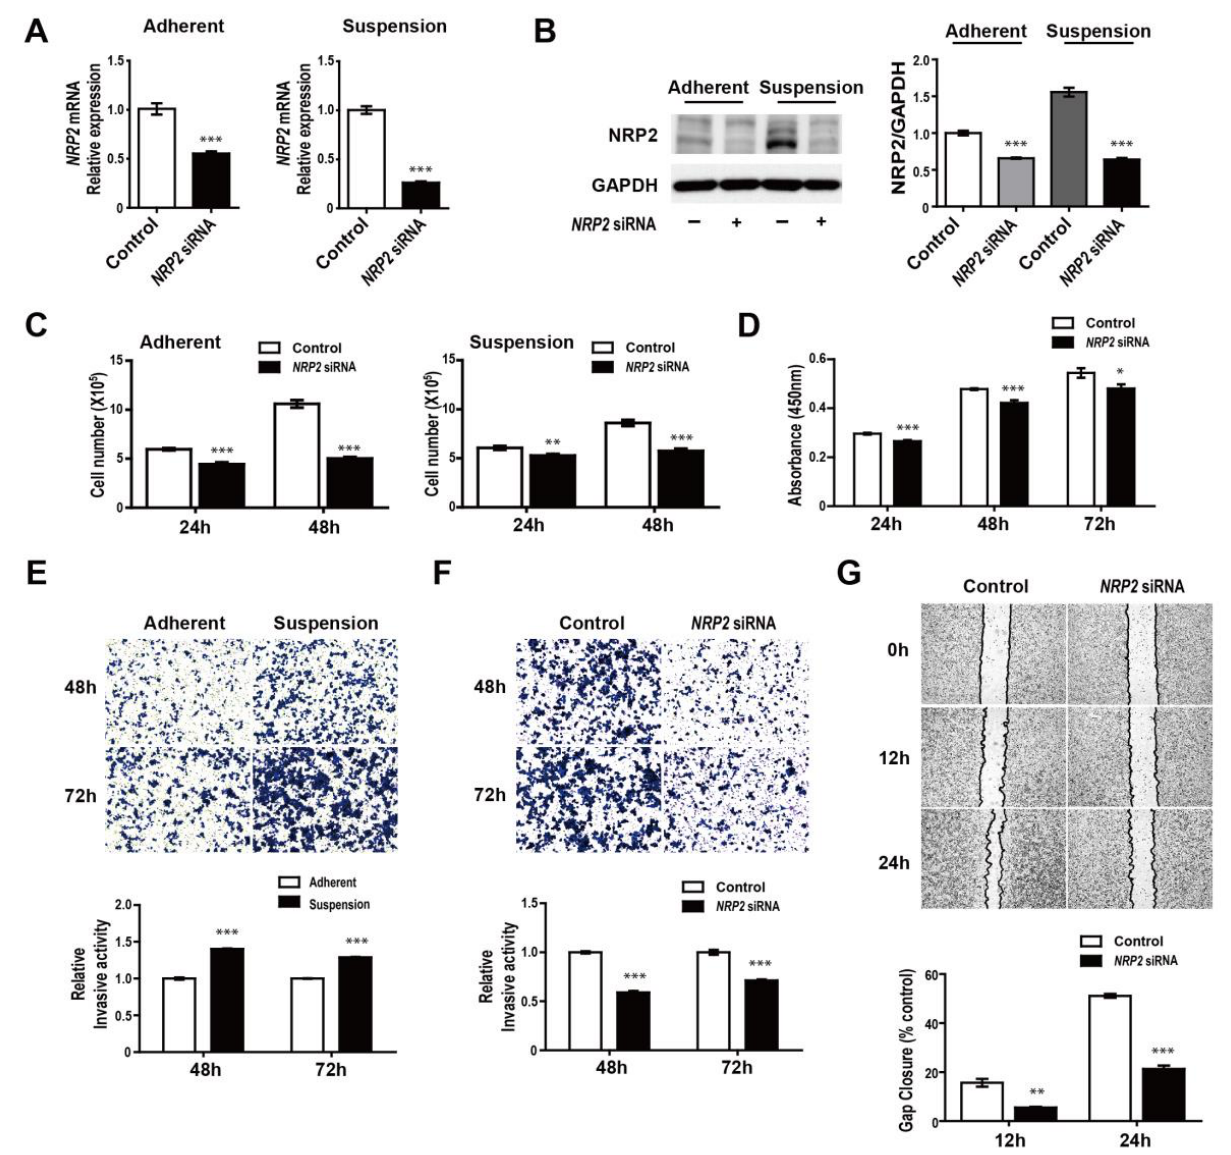
Figure 4. Effects of NRP2 knockdown on proliferation, migration, and invasion of MDA-MB-468 cells. ( A , B ) The NRP2 Figure 4 mRNA and protein expressions in adherent and suspension cells in response to NRP2 knockdown. ( C ) Cell proliferation assays in adherent and suspension cells transfected with NRP2 siRNA or negative control RNA. ( D ) WST-1 assays in adherent cells after NRP2 knockdown. ( E ) Trans-well invasion assays in adherent and suspension cells. ( F ) Trans-well invasion assays in suspension cells transfected with NRP2 siRNA or negative control RNA. ( G ) Migration assays in adherent cells transfected with NRP2 siRNA or negative control RNA. * p < 0.01, ** p < 0.001, and *** p < 0.0001 compared to controls calculated via an unpaired two-tailed Student’s t -test. Error bars denote the standard error of the